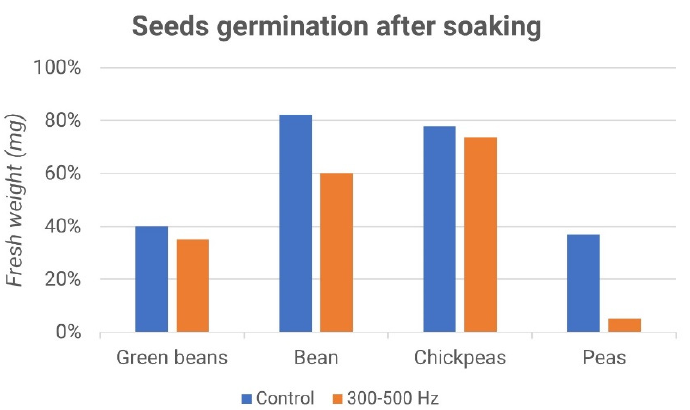
Figure 17. Seed germination after soaking: fresh weight vs. samples (green beans, bean, chickpeas and peas); control (blue) and 300–500 Hz stimulation (orange).